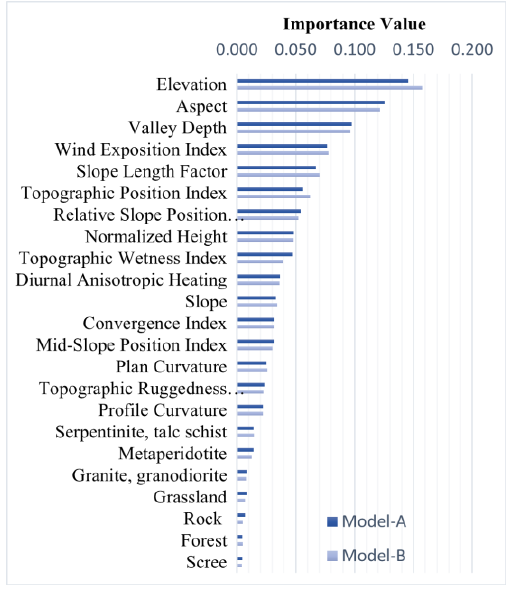
Figure 5. Feature importance of the RF